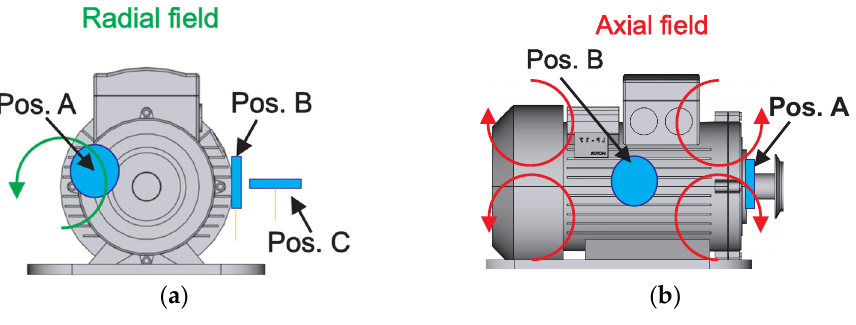
Figure 1. Stray flux components ( a ) Radial. ( b ) Axial.